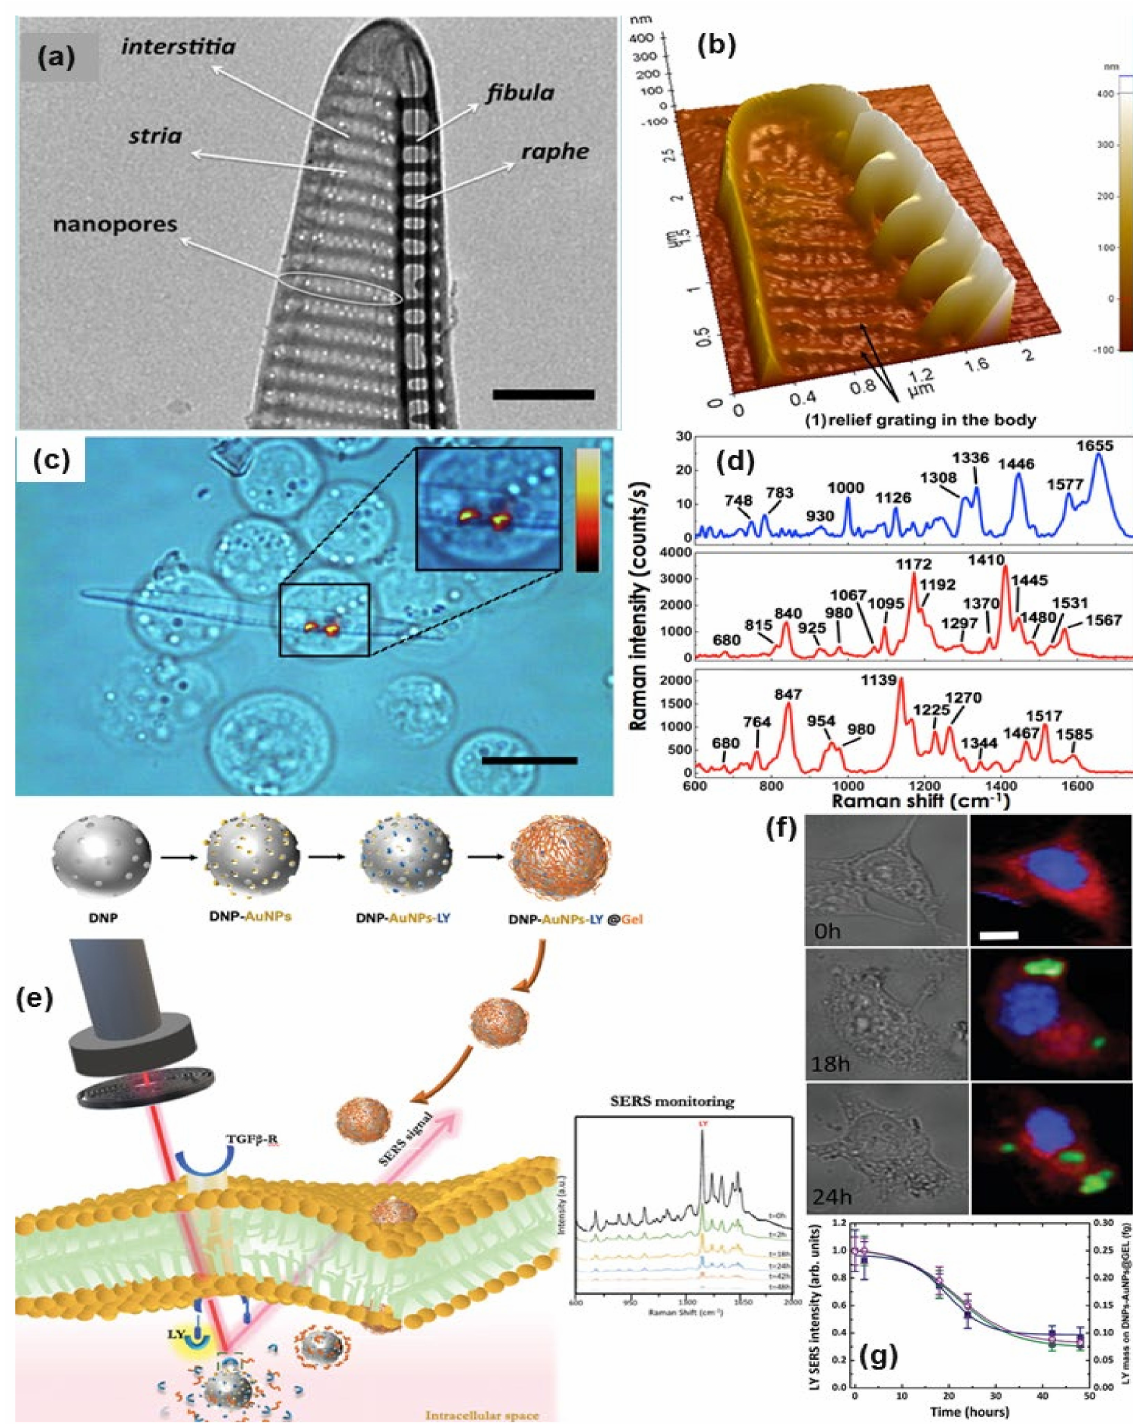
Figure 8. TEM and AFM image of a P. multistriata single valve is shown in panels ( a , b ). Panel ( c , d ) shows the optical image of REH LCs over a single metalized diatom valve and the conventional Raman spectrum of a single REH cell. Reprinted (adapted) with permission from ref. [121], Copyright 2018 American Chemical Society. The schematic diagram of hybrid nanosystem (diatomite nanoparticles-AuNPs-LY@Gel) synthesis and internalization in colorectal cancer (CRC) cells have been shown in panel ( e ). Panel ( f , g ) show optical image and Raman mapping images showing the internalization of DNP-AuNPs-LY@Gel (50 µ g mL − 1 ) into CRC cells after 0, 18, and 24 h of incubation (scale bar = 10 µ m) and time-dependent LY SERS signal from the hybrid nanocomplex in living CRC cells. Reproduced with permission from Wiley publications of ref.